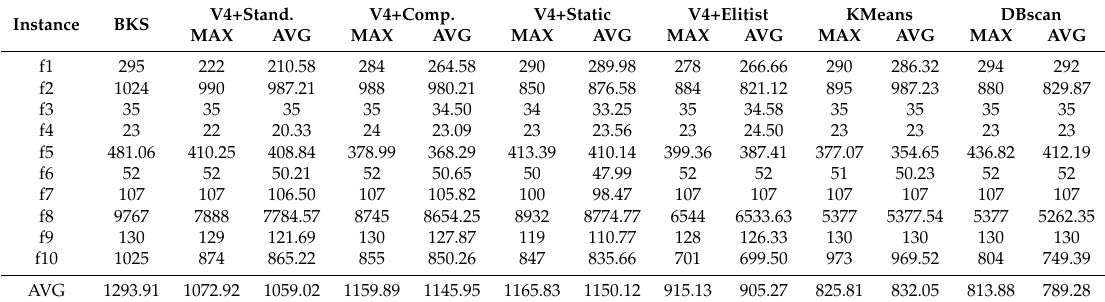
Table A19. CSA/KP—VShape 4—Two-steps vs. KMeans vs.